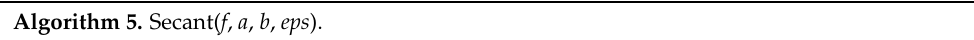
Algorithm 5. Secant( f , a , b , eps